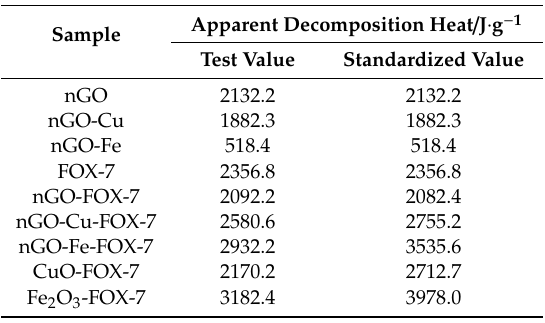
Table 1. Apparent decomposition heat of nGO, FOX-7 and their